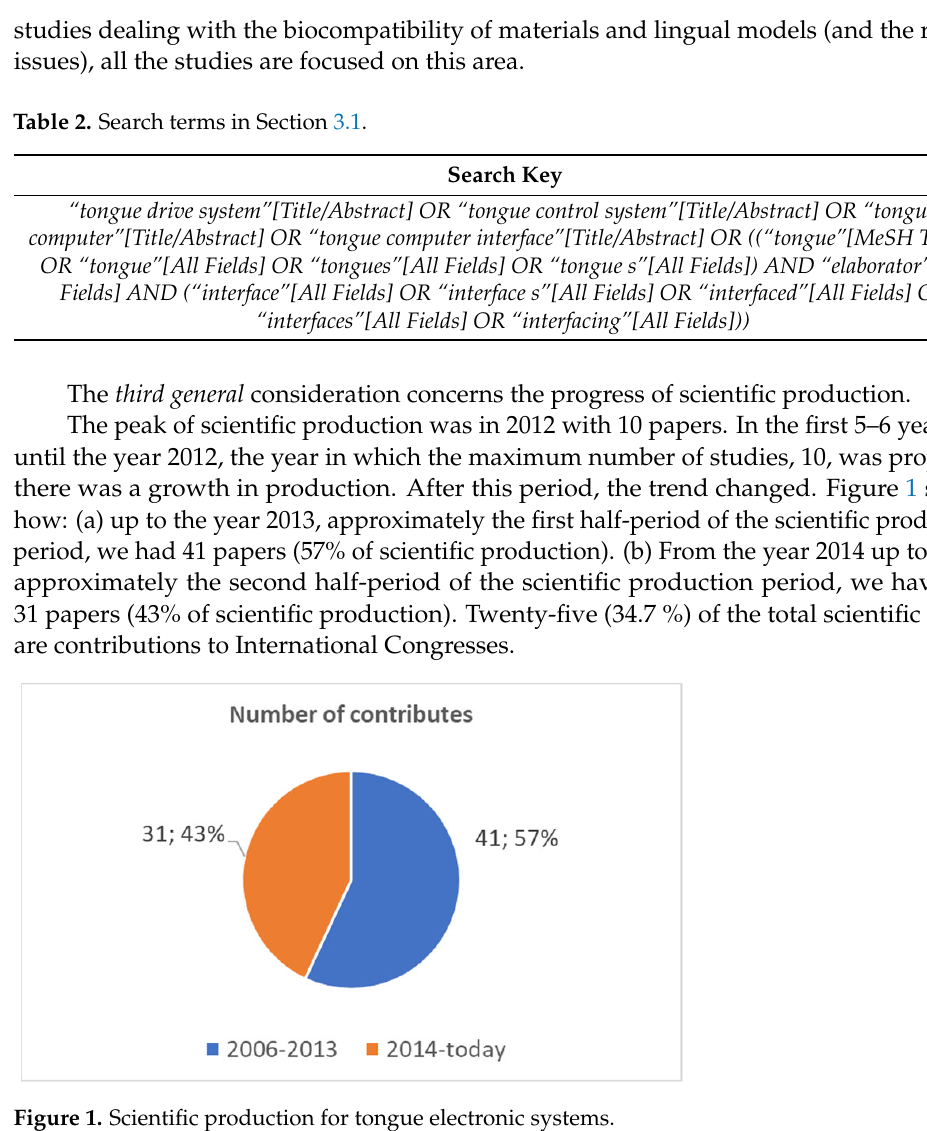
Figure 1. Scientific production for tongue electronic systems.